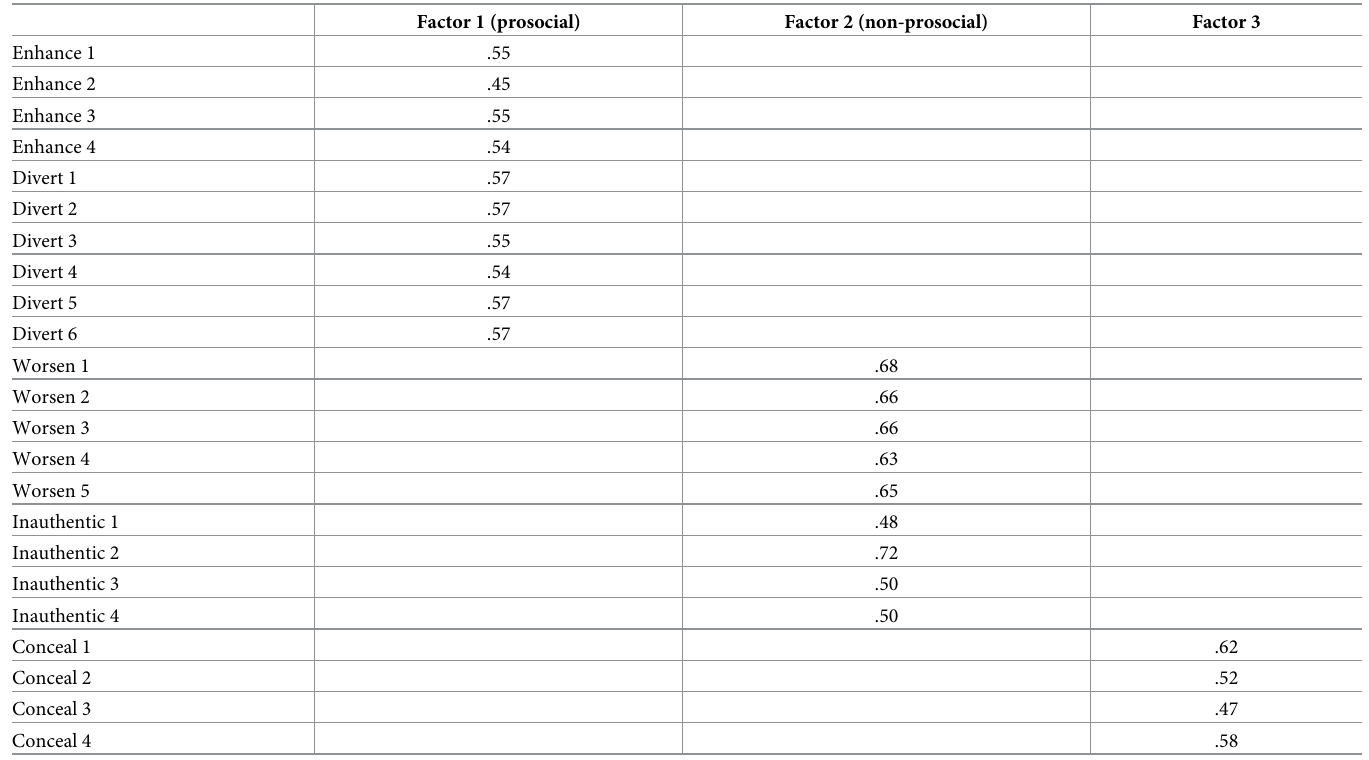
Table 3. Standardized factor loadings of MEOS-SF (23